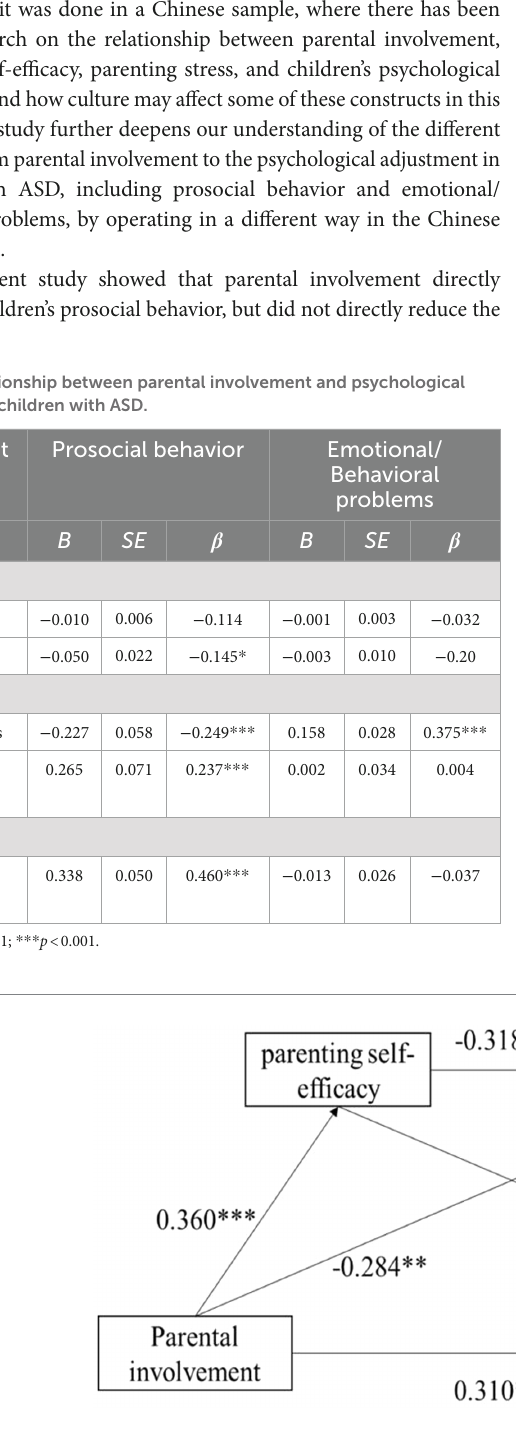
FIGURE 1 Mediation model testing the association between parental involvement and prosocial behaviors via parenting self-efficacy and parenting stress. * p < 0.05; ** p < 0.01; *** p <